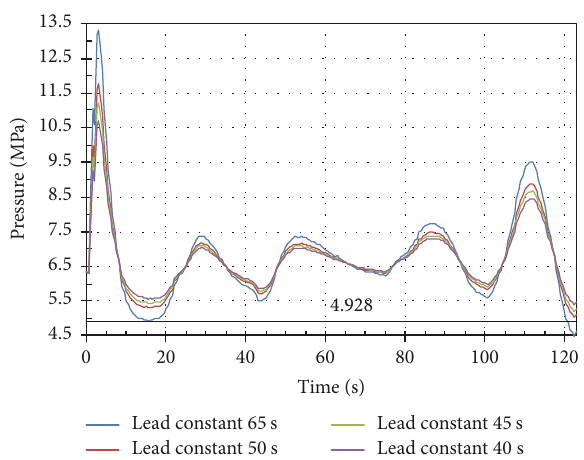
Figure 7: Calculated compensated low steam line pressures as a function of lead